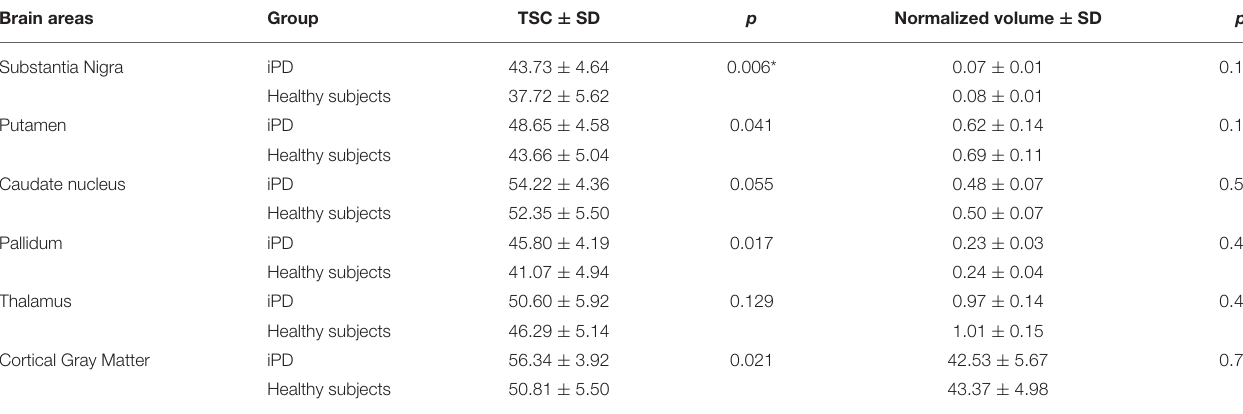
TABLE 2 | Mean Total sodium concentration (TSC) (wet tissue volume, mmol/l) and normalized volumes of brain regions of interest. Brain